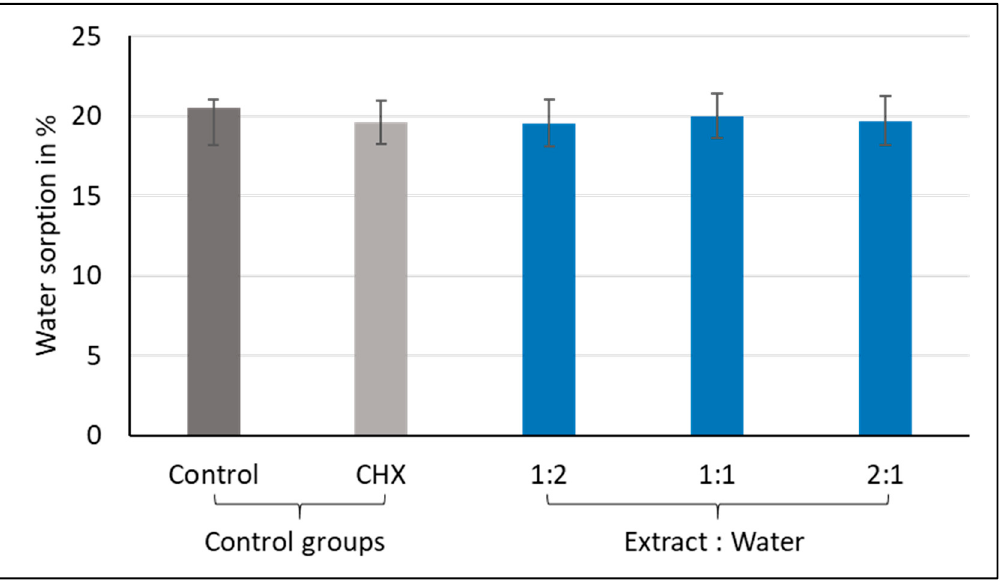
Figure 6. Mean water sorption values (%) showing intergroup comparison of the control, CHX, and three plant-modified groups (1:2, 1:1, 2:1).